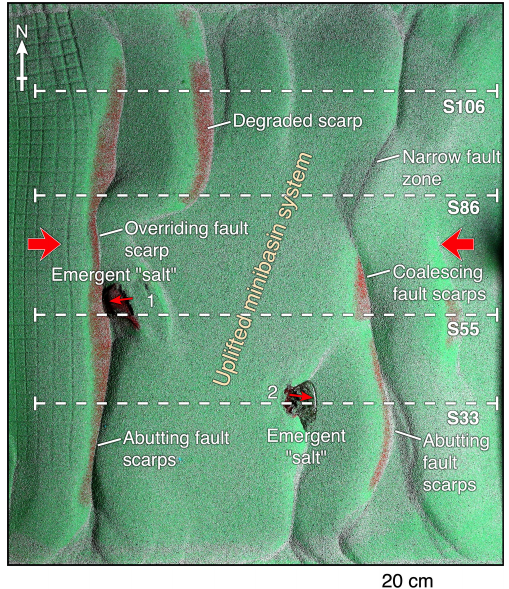
Figure 8. Overhead view of Model 1 after 25cm shortening. Di- apirs 1 and 2 are clearly visible in this view as emergent salt sheets. Section lines are those shown in Fig. 9. See text for further